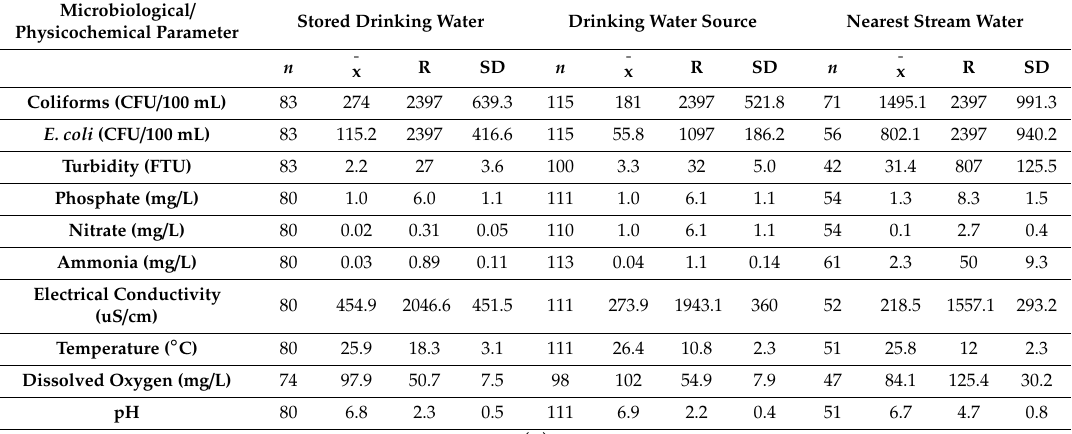
Table A3. Summary statistics for microbiological / physicochemical parameters measured in residential water ( a ) and ( b ) soil (water from soil) samples, Fiji typhoid case-control study, 2014–2015. n = sample ¯ x = mean; R = range; SD = Standard size;